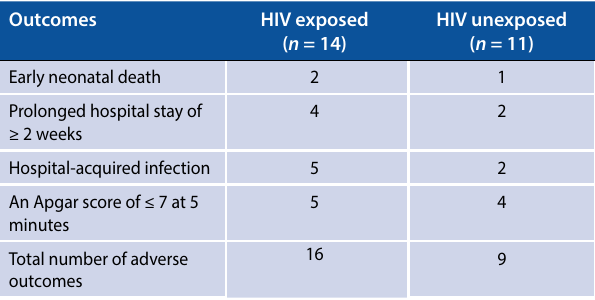
Note: HIV: human immunodeficiency virus